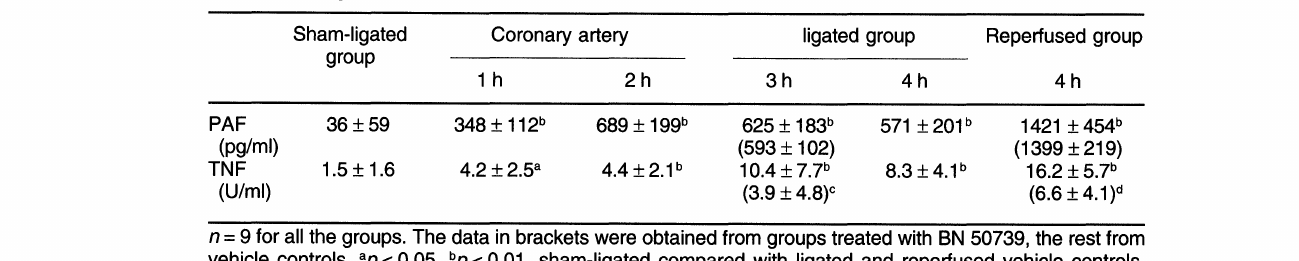
Table 2. Changes of blood PAF and TNF Sham-ligated